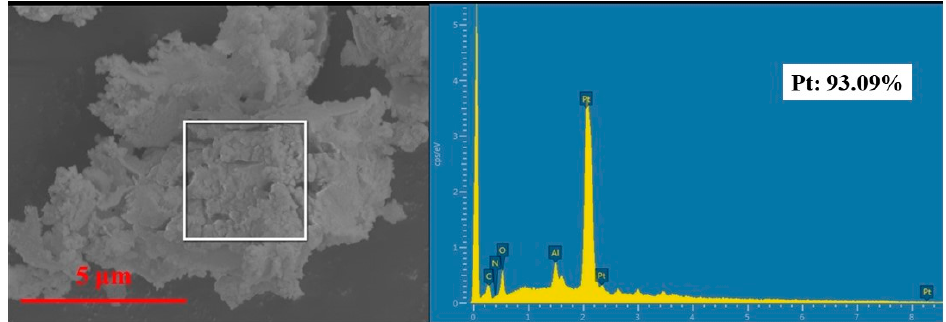
Figure 13. SEM–EDS of recovered Pt particles.